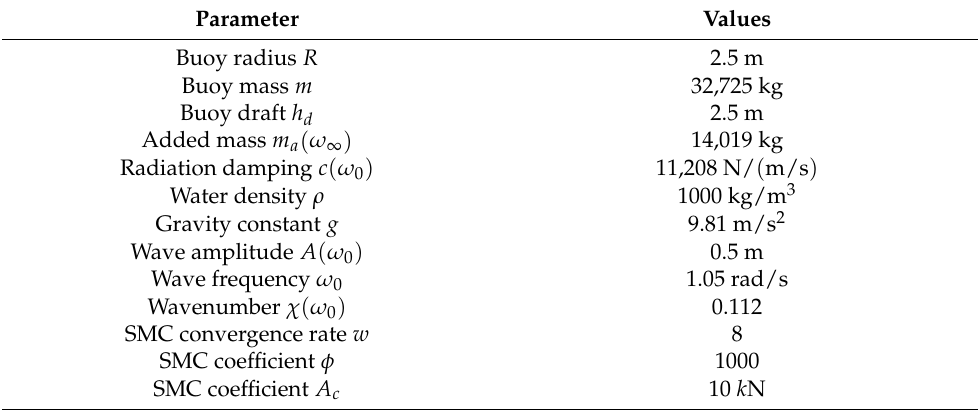
Table 1. Simulation parameters.